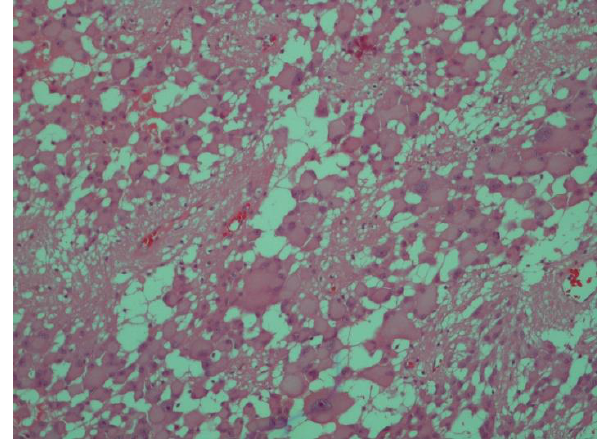
Figure 1. 1a. Pleomorphic Multinucleated Tumoral Giant Cells Characteristic of Subependymal Giant Cell Astrocytoma. Hematoxylin –eosine (H&E) staining. Magnification (x400).